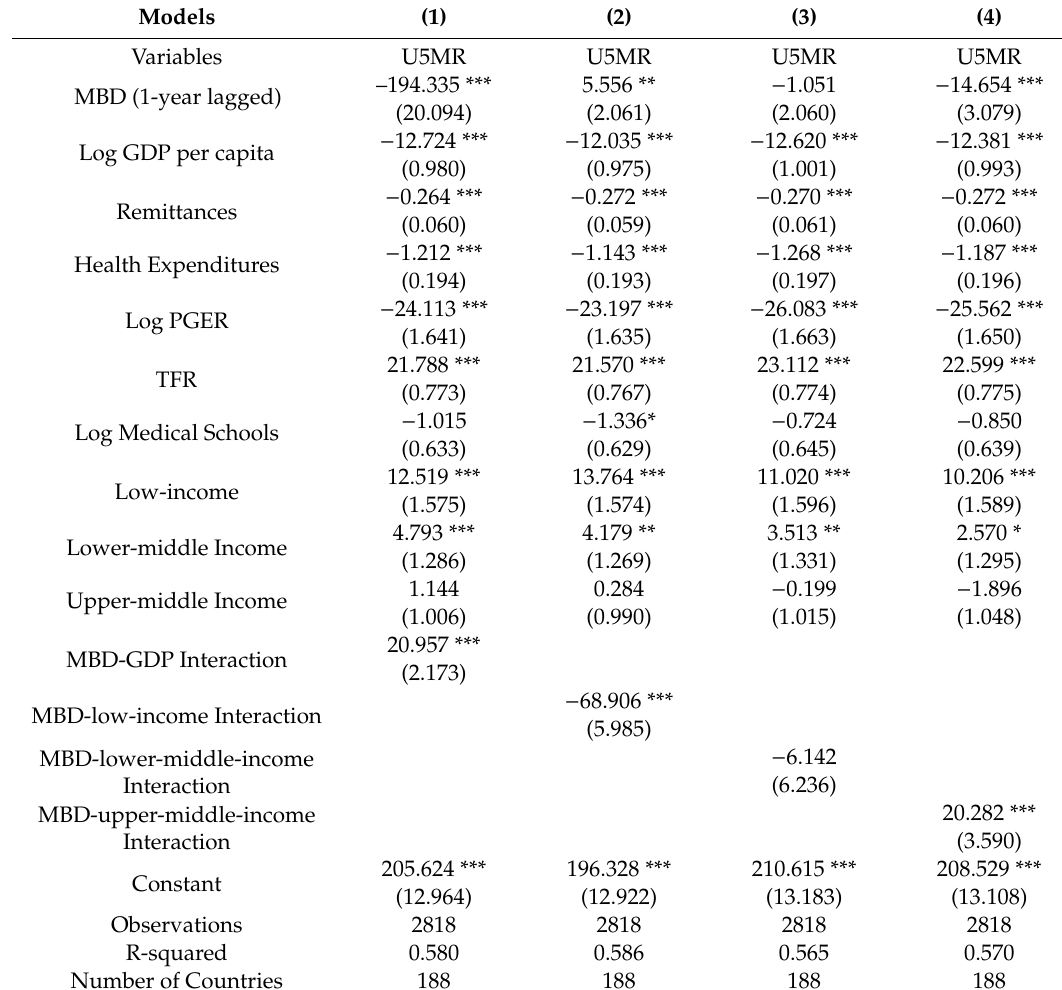
Table 7. Interaction e ff ects of MBD (1-year lagged) and levels of economy on U5MR in 188 countries over